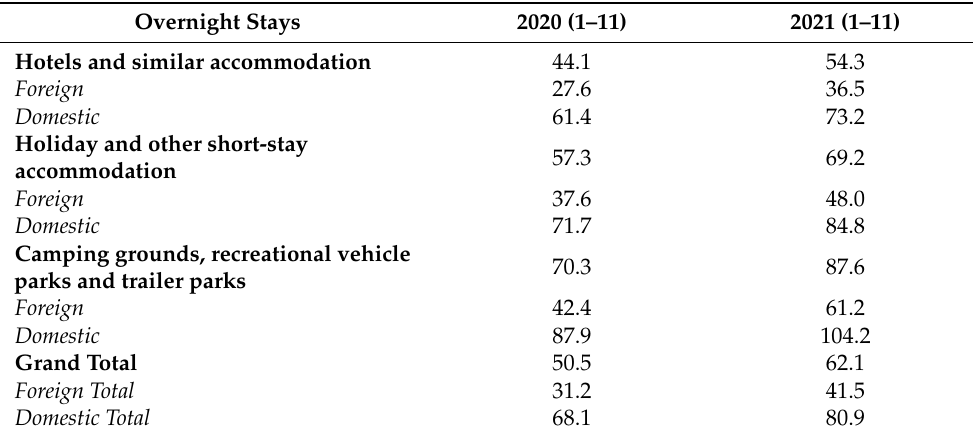
Table A1. Nights spent at tourist accommodation establishments—European Union 27 countries (2019 (1–11) =